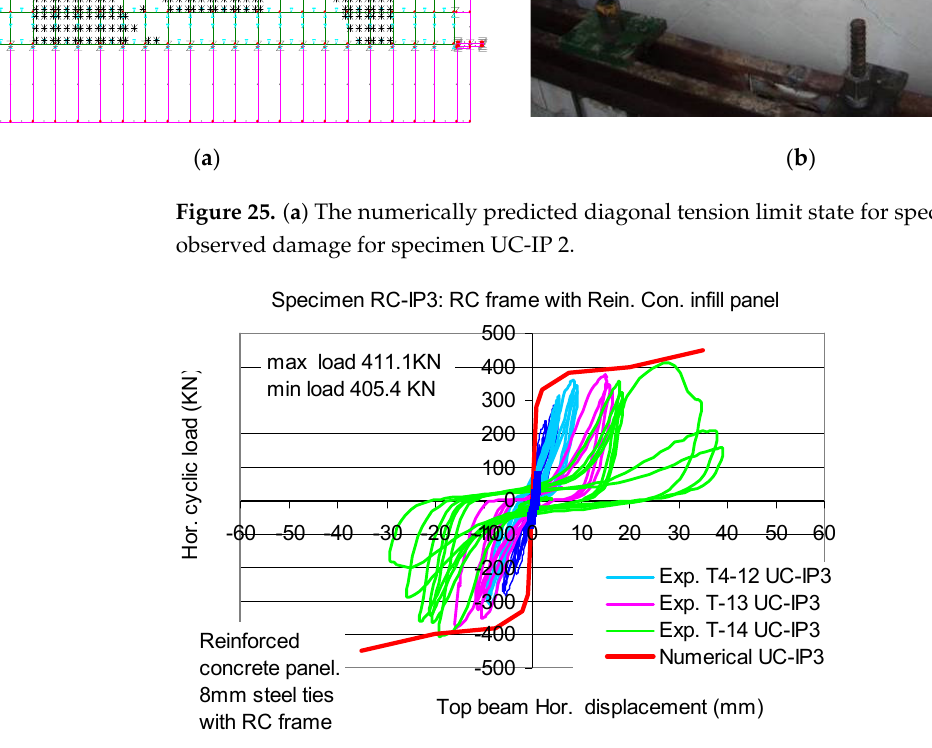
Figure 26. Horizontal displacement versus horizontal load cyclic response of specimen RC-IP 3. Comparison between observed and numerically predicted behaviour.